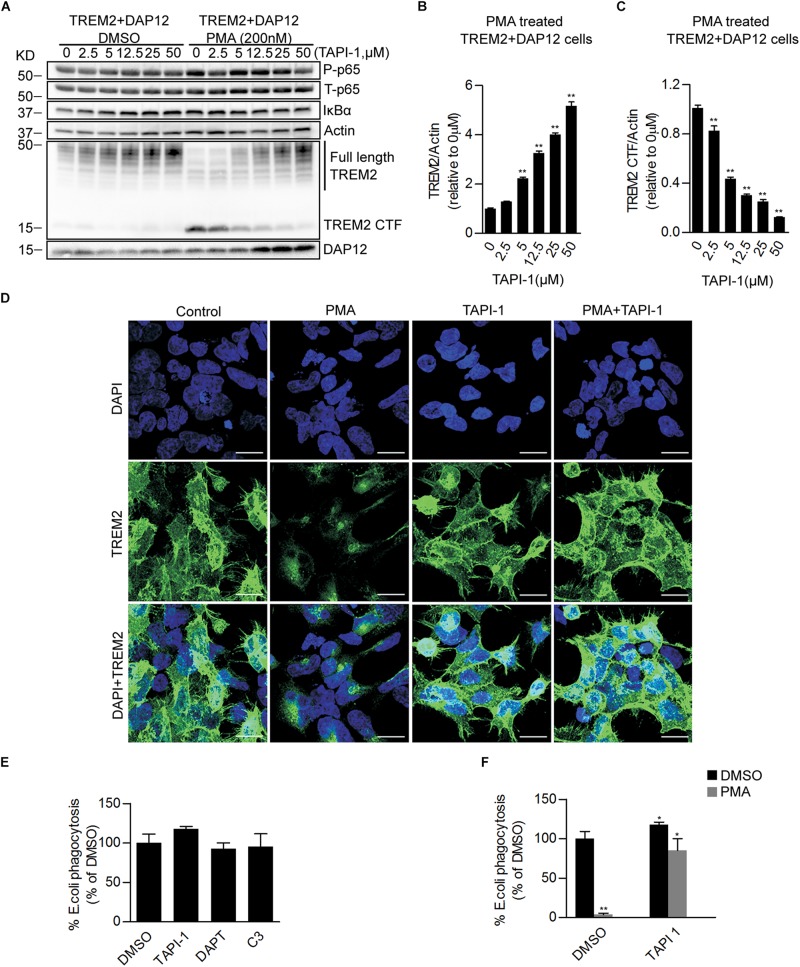
Pharmacological inhibition of ADAM proteases prevents PMA induced TREM2 shedding and increases phagocytosis in TREM2 + DAP12 HEK293 cells. (A) Western blot analysis of lysates from TREM2 + DAP12 HEK293 cells pretreated with different does of TAPI1 (0, 2.5, 5, 12.5, 25, and 50 μM) for 1 h, and then challenged with PMA (200 nM) for 1 h. The histograms represent the quantification of full length TREM2 levels normalized to Actin (B) and TREM2 CTF levels normalized to Actin used as a reference protein (C). Data are represented as means ± SD and expressed relatively to the level of full length TREM2 quantified in TREM2 + DAP12 HEK293 cells prior to TAPI-1 treatment; n = 4 for each experimental condition; statistical significance (∗∗p < 0.01) was evaluated by ANOVA followed by post hoc analyses with Bonferroni corrections. (D) Representative laser confocal images obtained following immunostaining with an N-terminal TREM2 antibody (green) and counterstaining with DAPI (blue) in HEK293 cells transfected with TREM2 + DAP12. Cells were pretreated with or without TAPI 1 (25 μM) for 1 h, and then challenged with PMA (200 nM) for 1 h prior to immunostaining. The white scale bar represents 20 μm. (E) Phagocytosis of pHrodo E. coli bioparticles conjugate in TREM2 + DAP12 transfected HEK293 cells treated with TAPI 1 (25 μM), DAPT (10 μM), or C3 (10 μM) for 1 h. Data are represented as means ± SD from at least two independent cell culture experiments and expressed as a percentage of the values obtained in DMSO (vehicle used to dissolve TAPI-1, DAPT, and C3) treatment conditions (control); n = 6 for each experimental condition; statistical significance (∗p < 0.05) was evaluated by ANOVA followed by post hoc analyses with Bonferroni corrections. (F) Phagocytosis of pHrodo E. coli bioparticles conjugate in TREM2 + DAP12 transfected HEK293 cells pretreated with TAPI-1 (25 μM) for 1 h and then challenged with PMA (200 nM) for 1 h. Data are represented as means ± SD from at least two independent cell culture experiments and expressed as a percentage of the values obtained in TREM2 + DAP12 HEK293 cells following DMSO treatment; n = 6 for each experimental condition; statistical significance (∗p < 0.05; ∗∗p < 0.01) was evaluated by ANOVA followed by post hoc analyses with Bonferroni correction.